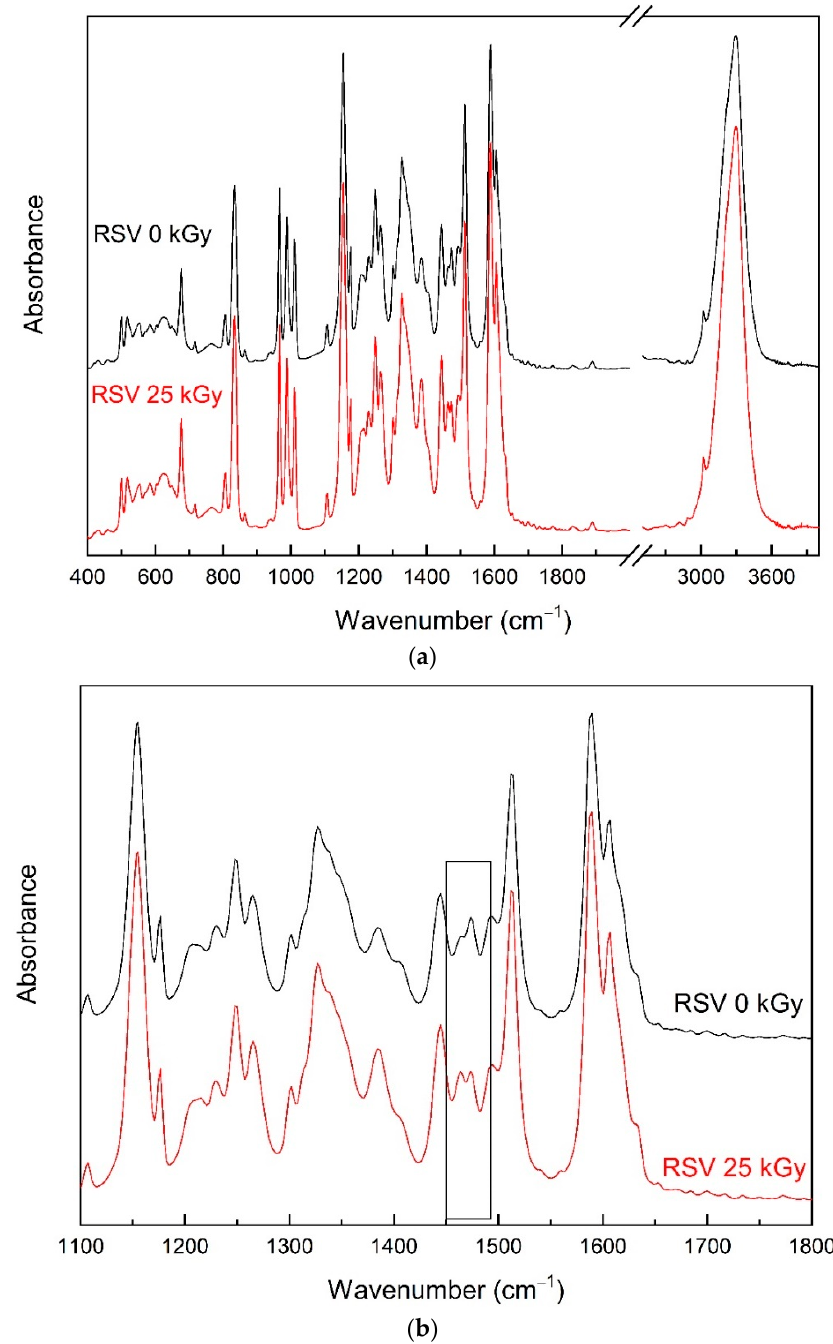
Figure 2. IR absorption spectra of non-irradiated (standard—black) and irradiated (red) resveratrol at room temperature: ( a ) range from 400 to 4000 cm − 1 ; ( b ) range from 1100 to 1800 cm − 1 .